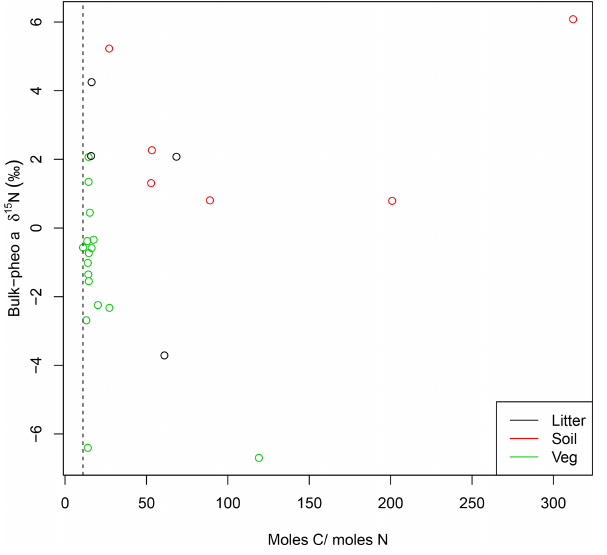
Figure 2. C / N ratios for pheo a isolates higher than 11 (dashed line) reveal contamination by carbon compounds. Effect of this contam- ination on pheo a δ 15 N is investigated by comparing pheo a molar C / N with the offset between pheo a and bulk δ 15 N for litter (black), soil (red), and vegetation (green) samples. Lack of a systematic re- lationship between high C / N ratios and greater similarity of pheo a δ 15 N to bulk values is evidence against contamination of the pheo a samples by N from the greater bulk sample.